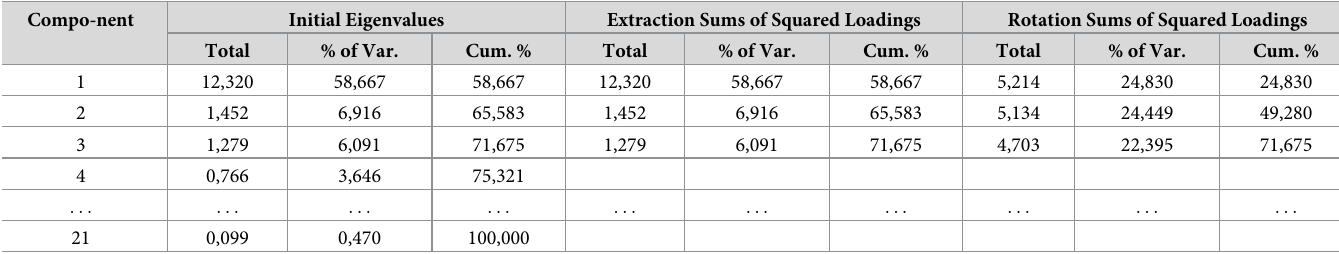
Table 3. Factor analysis results—Total variance explained by principal component analysis. Compo-nent Initial Eigenvalues Extraction Sums of Squared Loadings Rotation Sums of Squared Loadings Total % of Var. Cum. % Total % of Var. Cum. % Total % of Var. Cum.